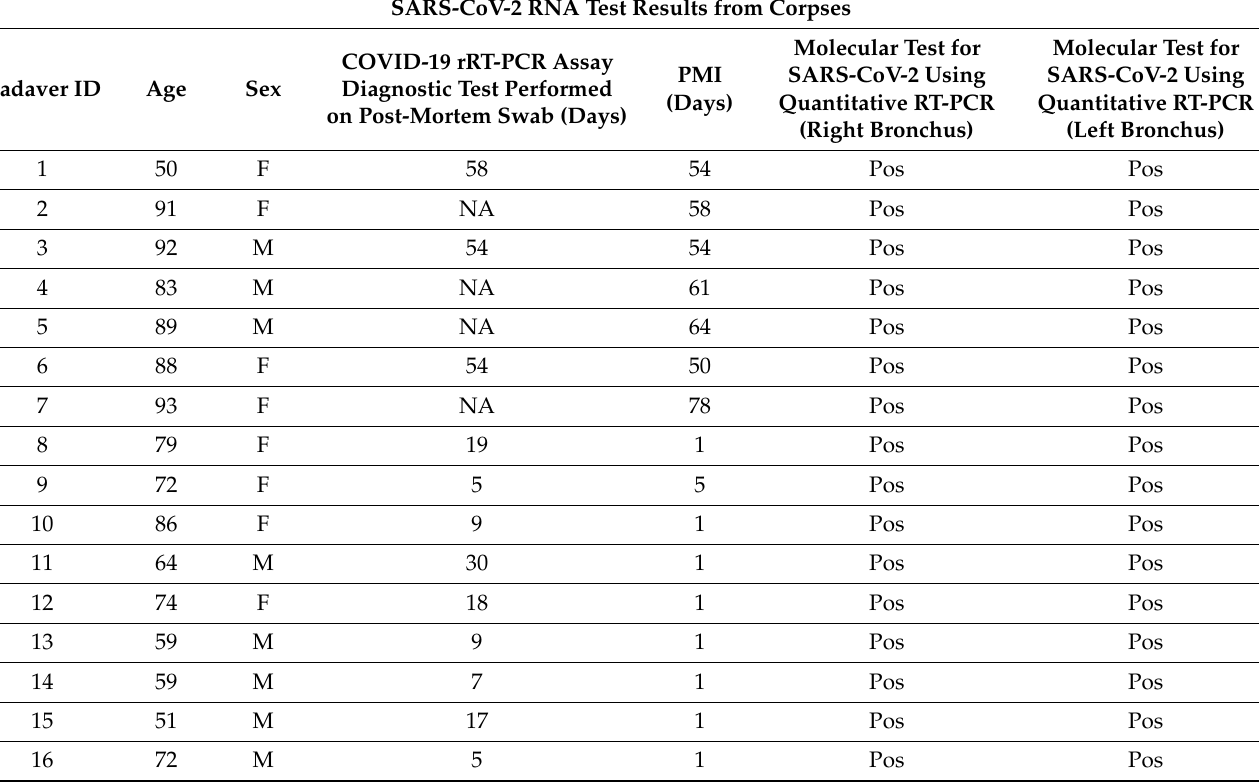
Table 1. Molecular test for SARS-CoV-2 using quantitative rRT-PCR performed at time T1 (during the autopsy) is positive in all samples of low respiratory airways. These results are neither influenced by the CDTPMS (period of time elapsed between the COVID-19 diagnostic test and the post-mortem swabs) nor by